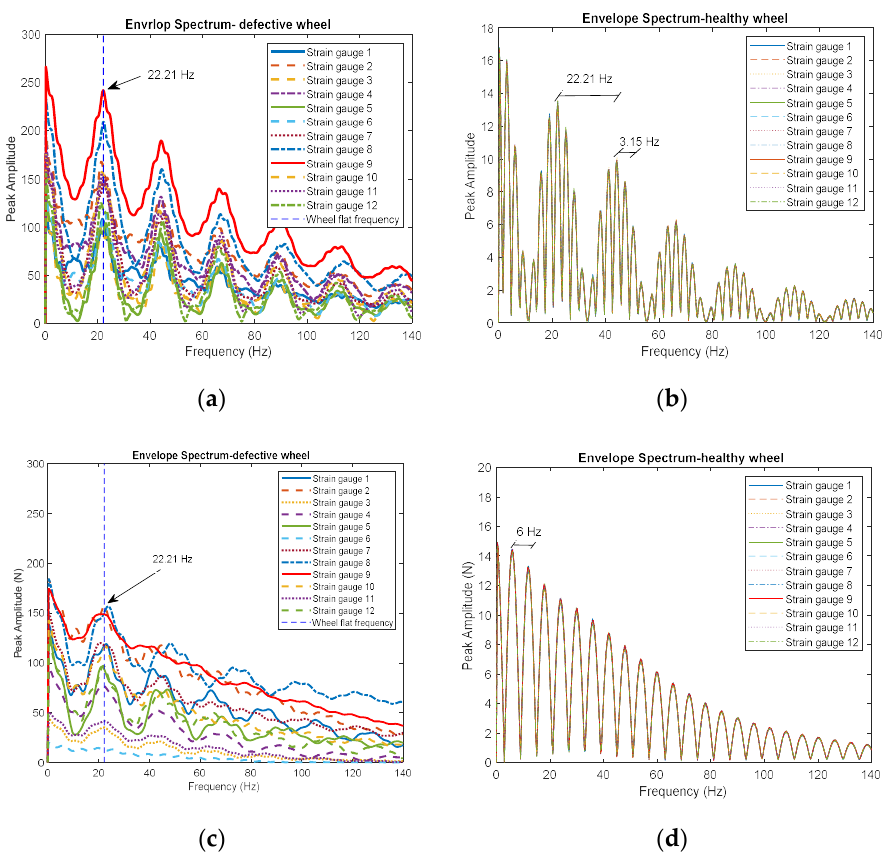
Figure 9. Envelope spectrum analysis for the 12 strain gauges (layout scheme 1) for the Alfa Pendular and the freight wagon, considering the unevenness profile of the track, ( a ) a defective wheel Alfa Pendular, ( b ) a healthy wheel Alfa Pendular, ( c ) a defective wheel freight wagon, and ( d ) a healthy wheel freight wagon.